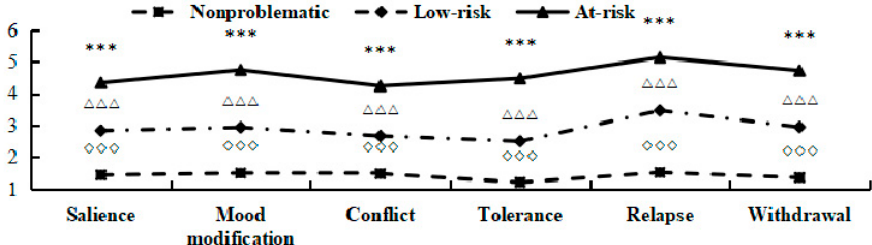
Figure A1. The average scores of the three latent classes based on the dimensions of PPCS. Note: PPCS = Problematic Pornography Consumption Scale, range = 1 – 7; *** p < 0.001 indicate that the score of at-risk group was significantly higher than that of low-risk group; △△△ p < 0.001 indicate that the score of low-risk group was significantly higher than that of non-problematic group; ◇◇◇ p < 0.001 indicate that the score of at-risk group was significantly higher than that of non-problematic group. The same below.